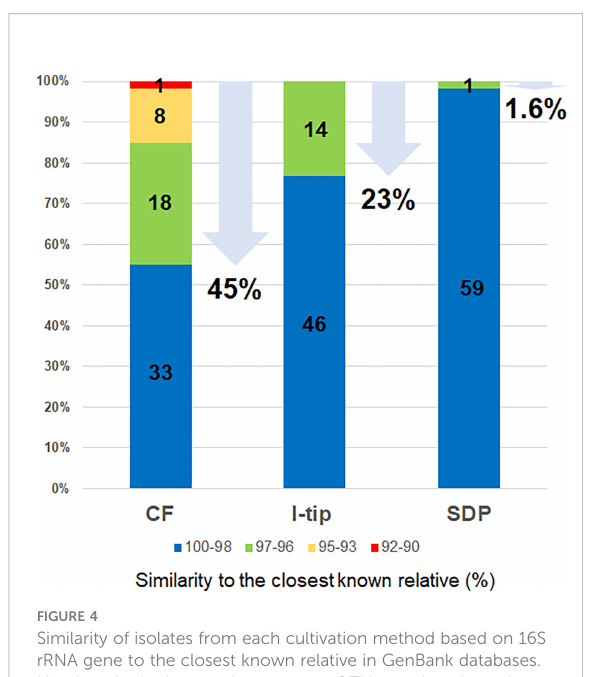
FIGURE 4 Similarity of isolates from each cultivation method based on 16S rRNA gene to the closest known relative in GenBank databases. Numbers in the bar graphs represent OTUs numbers in each similarity level and numbers under arrows represent the ratio of novel species, de fi ned as a strain ≤ 97% 16S rRNA similarity to the closest known